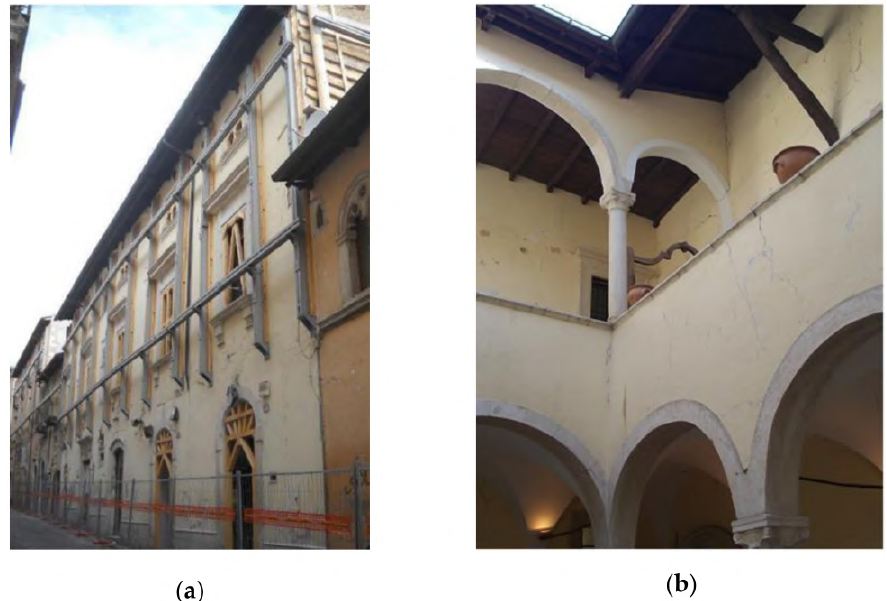
Figure 5. ( a ) Photo of the façade of Burri Gatti palace after the 2009 earthquake; ( b ) photo of the palace entrance hall.